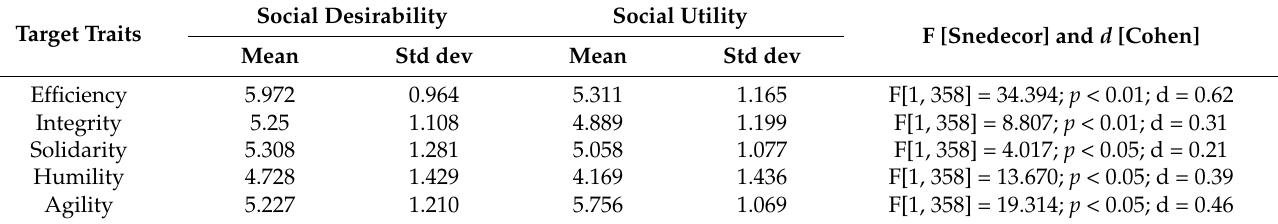
Table 2. Means and effects of the type of judgments (desirability and utility), considered globally. Target Traits